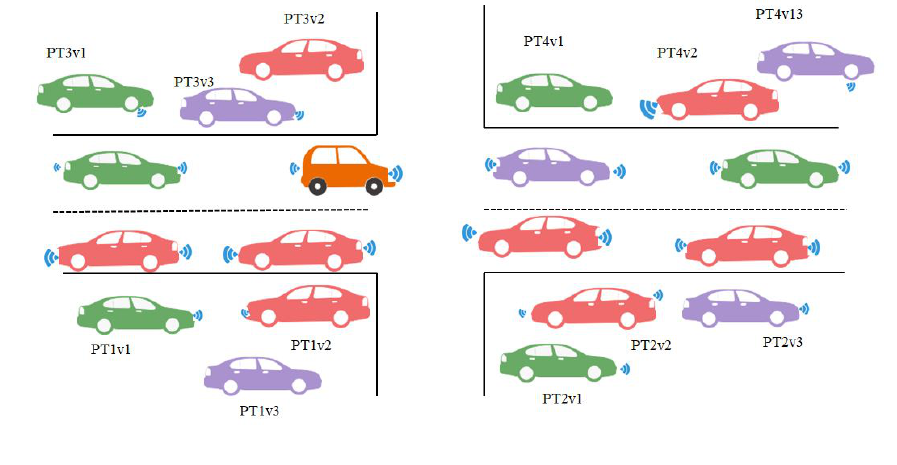
Figure 11. Parking Shift